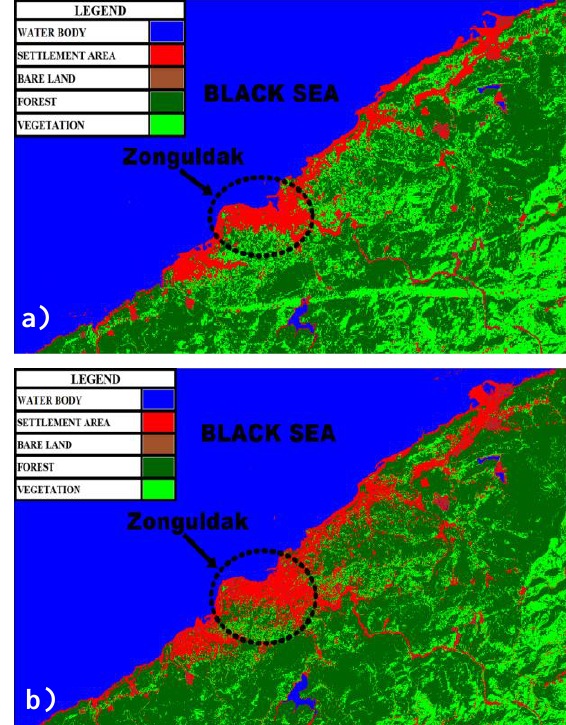
Figure 2. LULC images of the study area; a) Landsat-8 derived